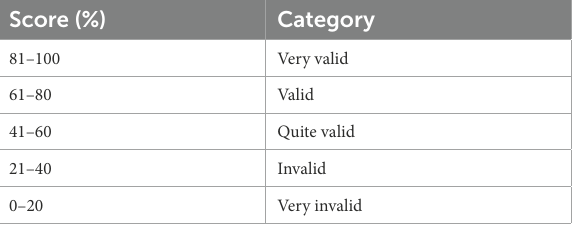
TABLE 1 Product development validity criteria.